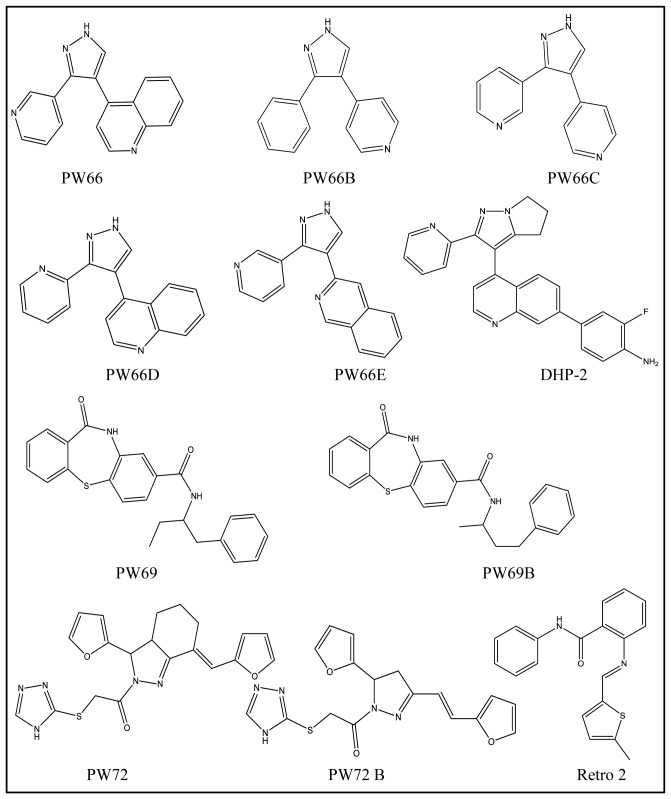
2D structure of compounds described in this work.